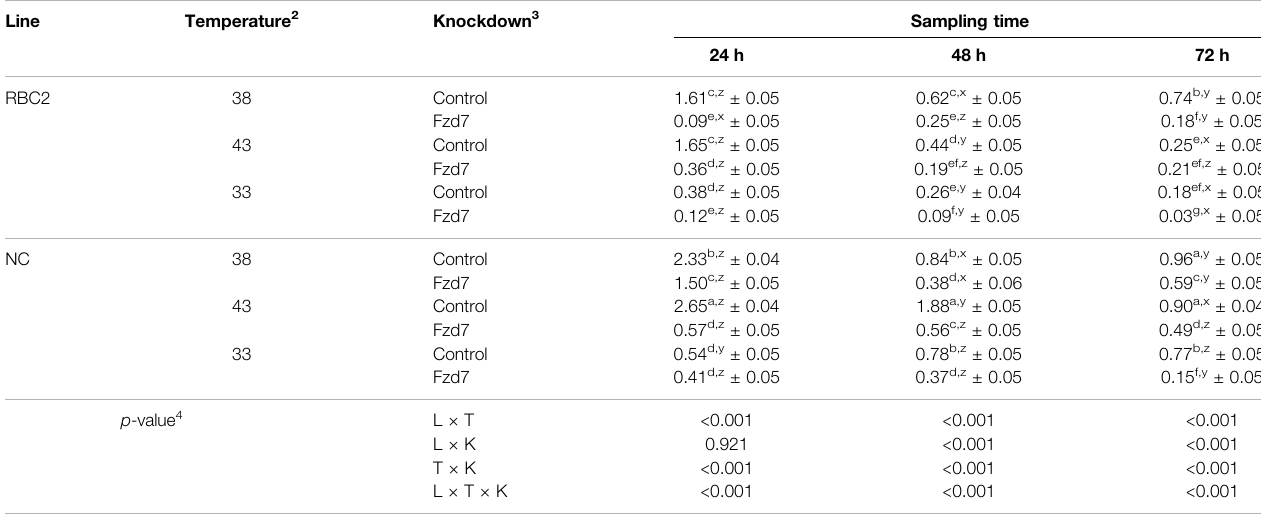
TABLE 6 | Effect of temperature and knockdown of frizzled-7 ( Fzd7 ) on lipid content during differentiation of randombred control line 2 (RBC2) and modern commercial line (NC) satellite cells 1 .